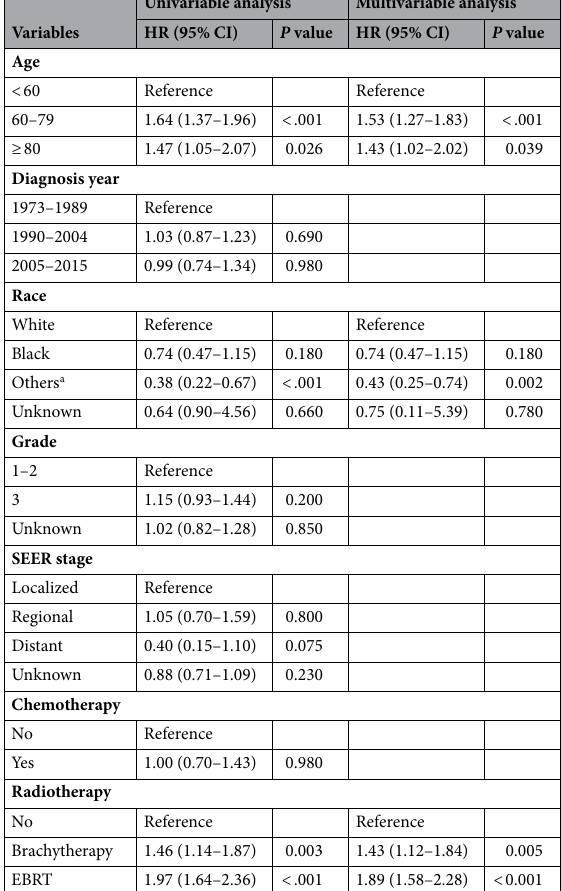
Table 3. Univariable and multivariable competing risk analysis of risk of developing SBC in EC survivors. CI, confidence interval; HR, Hazard ratio; EBRT, external-beam radiotherapy; EC, endometrial cancer. a Including Asian and American